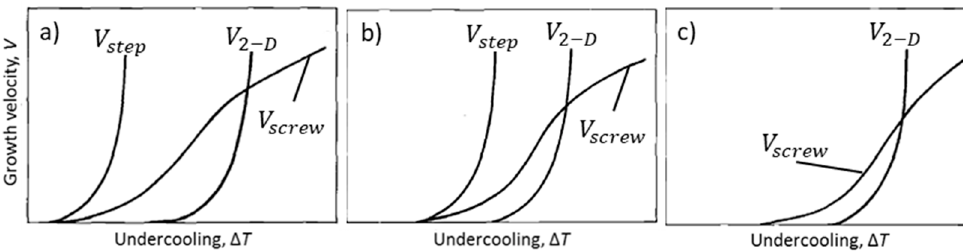
(cid:16) (cid:17) Figure 30. Suggested ∆ T − V correlation for 1010 and (0001) crystal faces of graphite growing in melts of various purity, reproduced from [36]: ( a ) In melt with deleterious surface-active impurities (S, O, Al etc.); ( b ) in pure melt; ( c ) in melt with reactive impurities (Mg, Ce etc.).